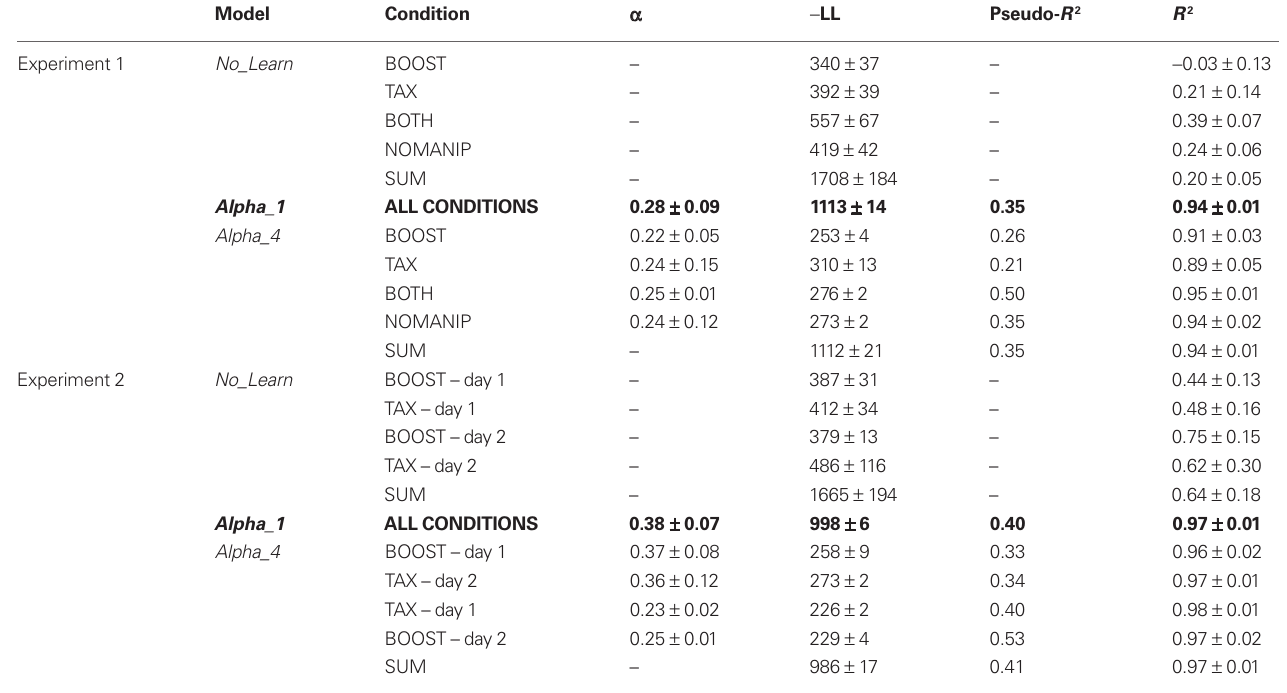
Table 1 | reinforcement learning model